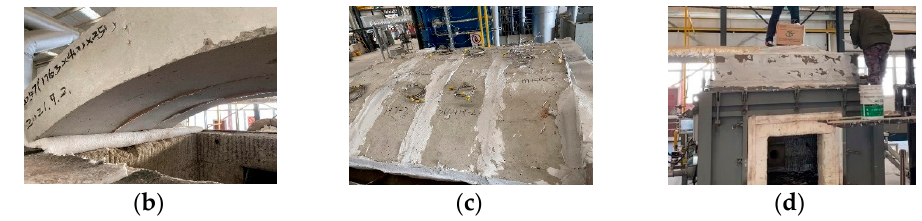
Figure 4. ( a ) Hoist the tunnel lining ( b – d ) and seal the lining structure over the high-temperature open-hearth furnace.